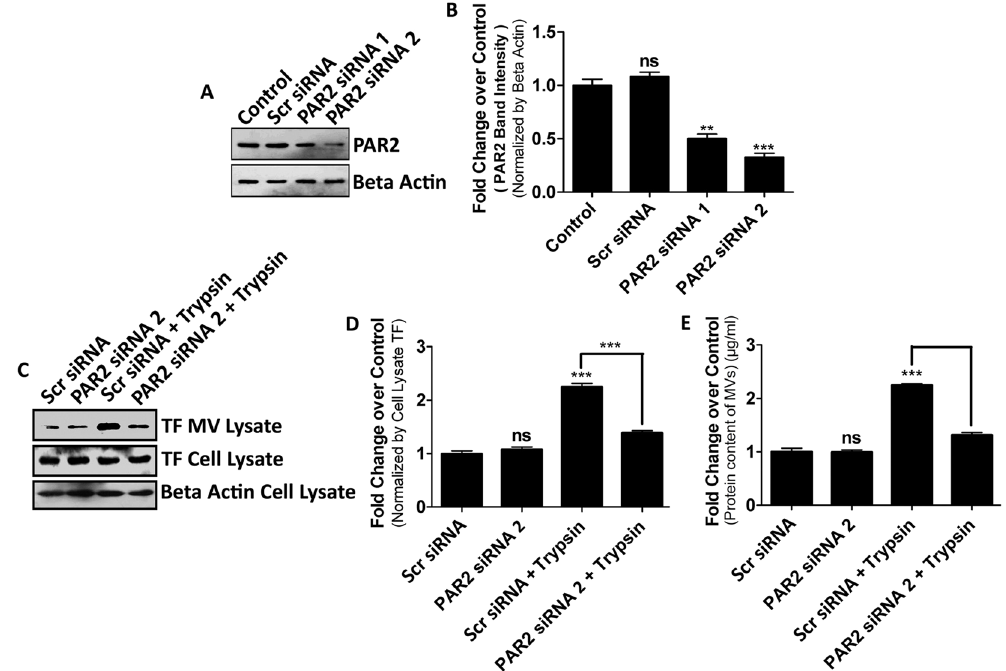
Figure 2. Trypsin-mediated Microvesicles Generation from MDA-MB-231 Cells Is Happening Through PAR2 Receptor Activation. MDA-MB-231 cells were transfected with 100 nM concentration of two different siRNAs against PAR2 alongside a scrambled control. 48 hours later, cells were lysed and PAR2 knock-down was analyzed by western blotting with PAR2 specific antibody and quantification was made by GraphPad Prism5 ( A ) and ( B ). Cells were transfected with PAR2 siRNA 2 followed by the addition of trypsin. 24 hours later, MVs quantification was done by western blotting with TF marker ( C ) and ( D ). MVs quantification was also performed by Bradford assay ( E ). Data presented here are as Mean + / − S.E. of the Mean. Differences are considered to be statistically significant at p < 0.05 using student’s t-test after performing the experiments three times whereas ‘ns’ represents non-significant